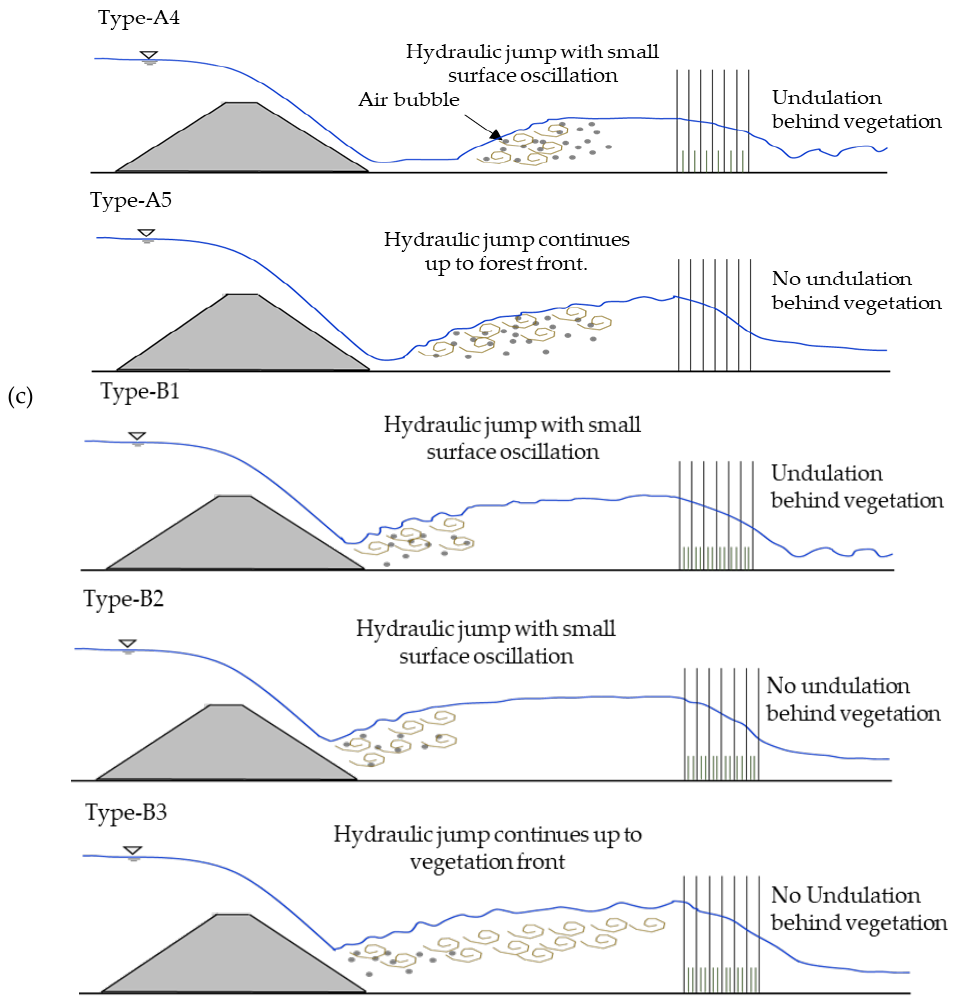
Figure 4. Sketch to classify different types of hydraulic jump observed in this investigation: ( a ) No hydraulic jump occurs with embankment model and without forest model ( h c : critical flow depth; h EM : water depth downstream of embankment model); hydraulic jump occurs ( b ) on the floor of the flume and ( c ) on the downslope of the embankment model in the hybrid defense system.